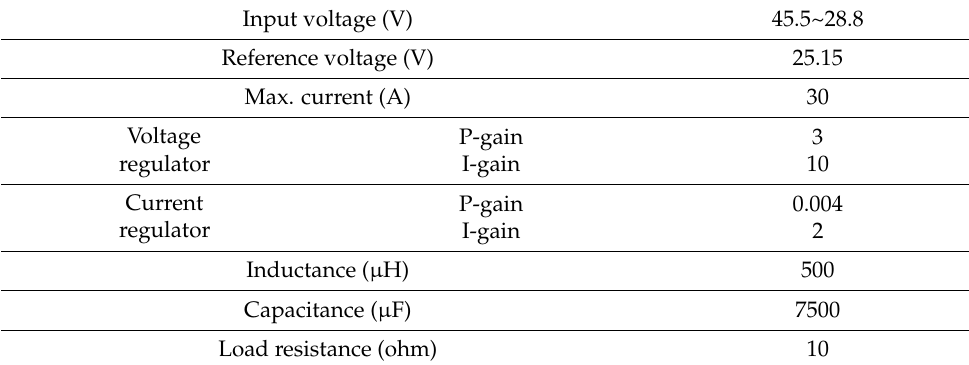
Figure 8. Circuit schematic for converter model simulation.